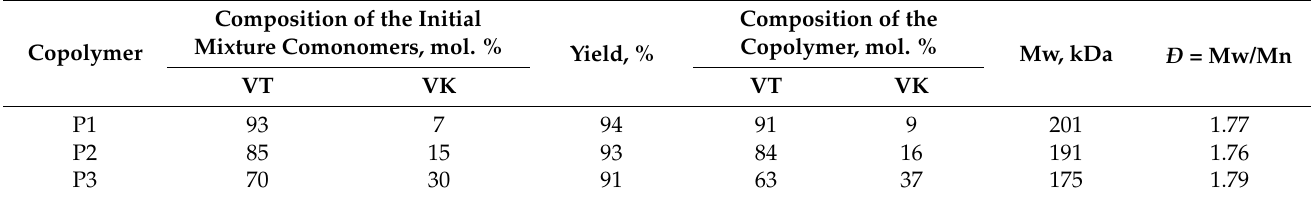
Table 1. Copolymerization conditions and characteristics of P1–P3 poly(VT– co –VK) copolymers ( C AIBN = 3 × 10 − 2 mol/L, 60 ◦